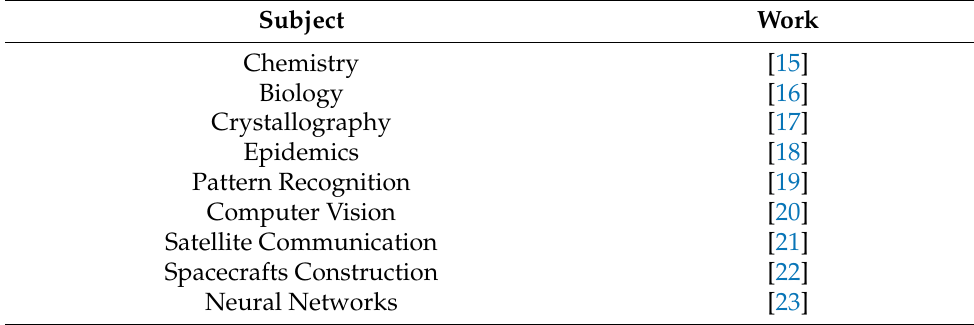
Table 1. Works devoted to the applications of the graph energy theory. In the case of pattern recognition, the applications deal with military